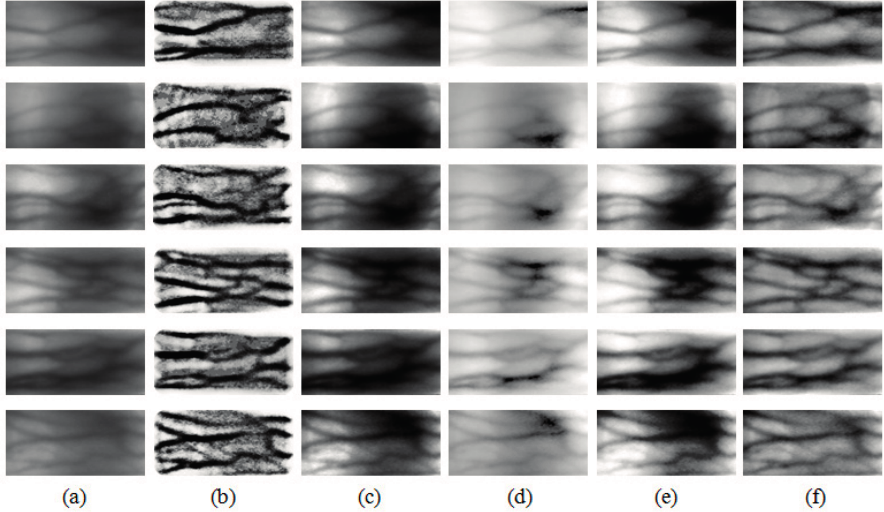
Figure 10. Comparison of finger vein image enhancement using different methods on MMCBNU_6000: ( a ) original ROI images, and enhanced images using ( b ) IN method; ( c ) SR method; ( d ) SSR method; ( e ) HE method; and ( f ) the proposed GFSSR